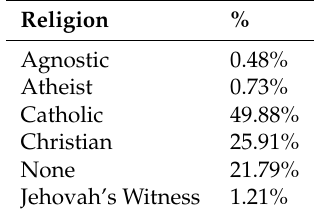
Table 1. Distribution of individuals by religion.